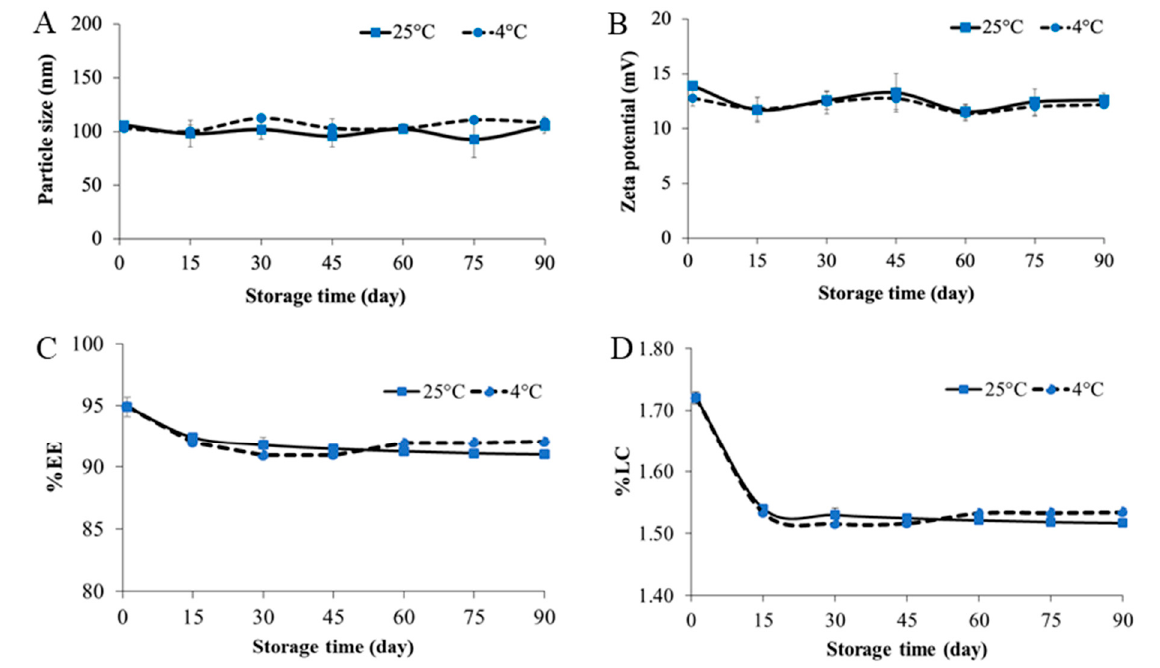
Figure 9. Stability studies showing the particle size ( A ), zeta potential ( B ), retention of CUR-2GE in the CUR-2GE-Ch-IONPs through EE ( C ) and LC ( D ) for up to 90 days of storage at 4 °C and 25 °C.